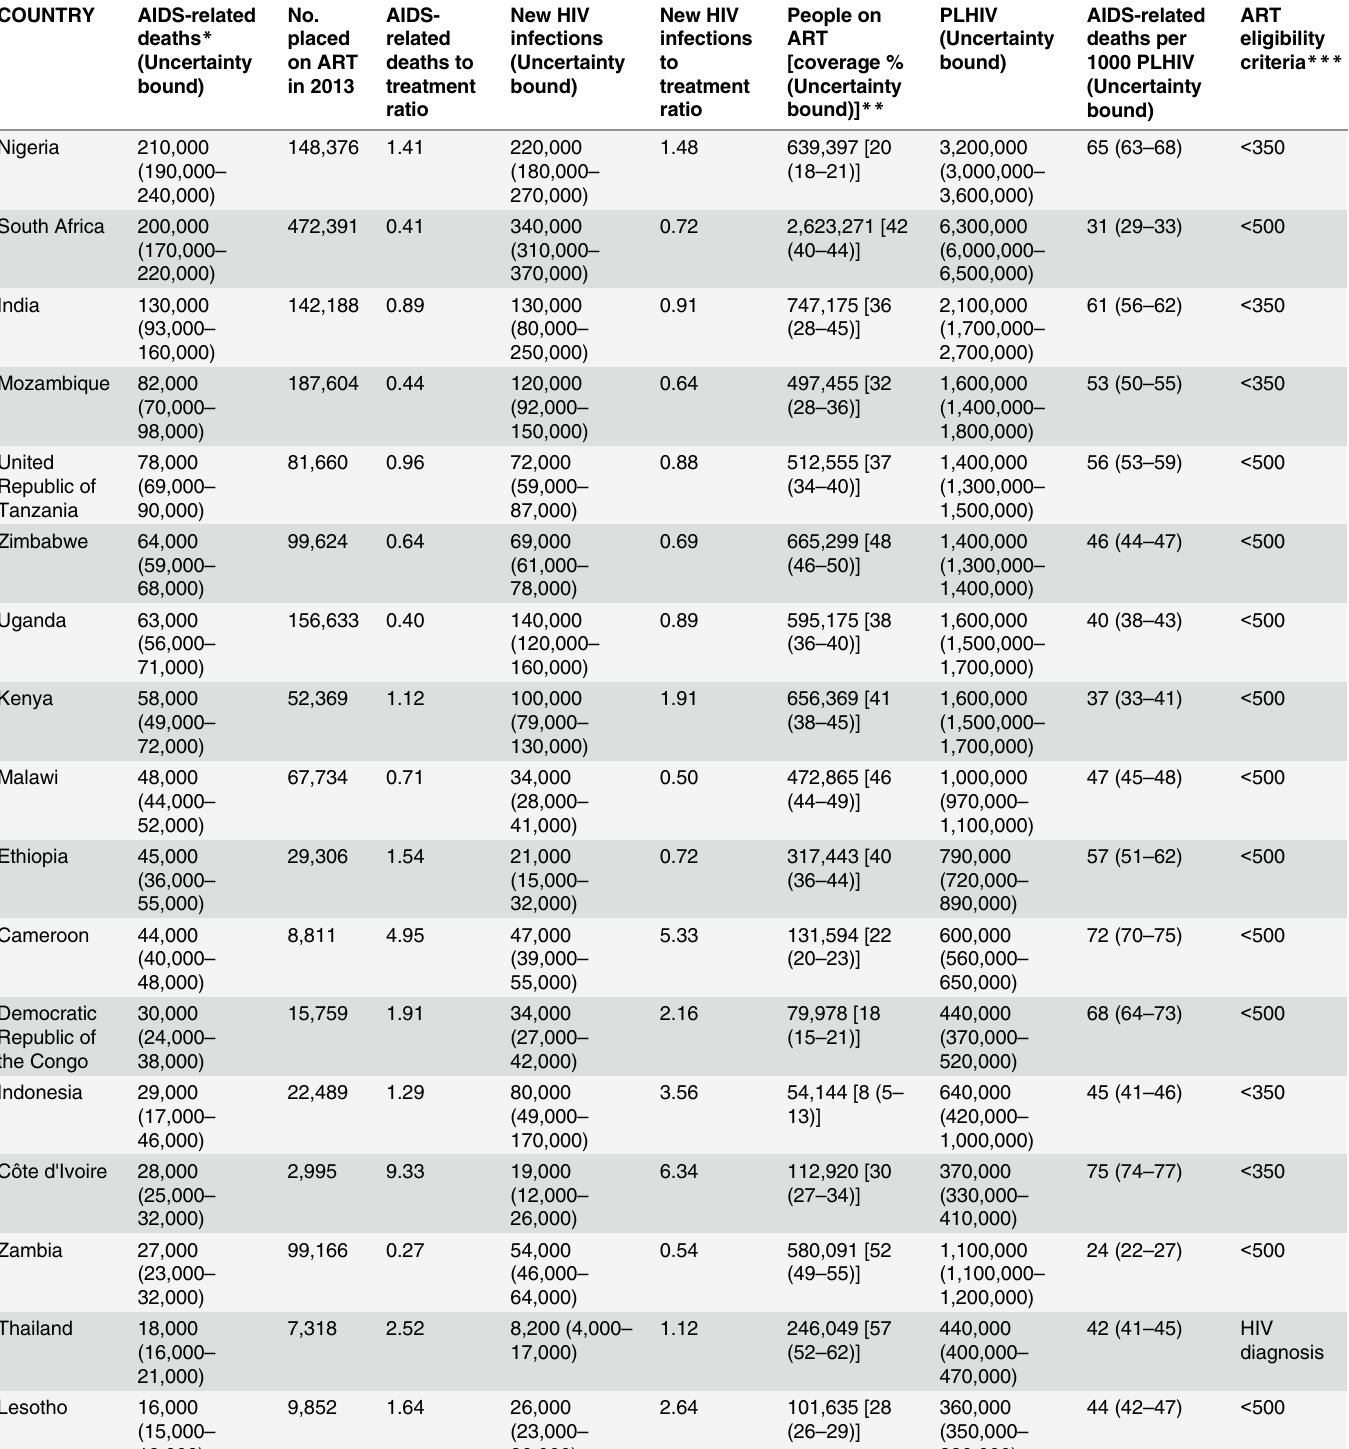
Table 1. Estimated deaths per 1000 people living with HIV for top 30 countries with the highest burden of estimated AIDS deaths,